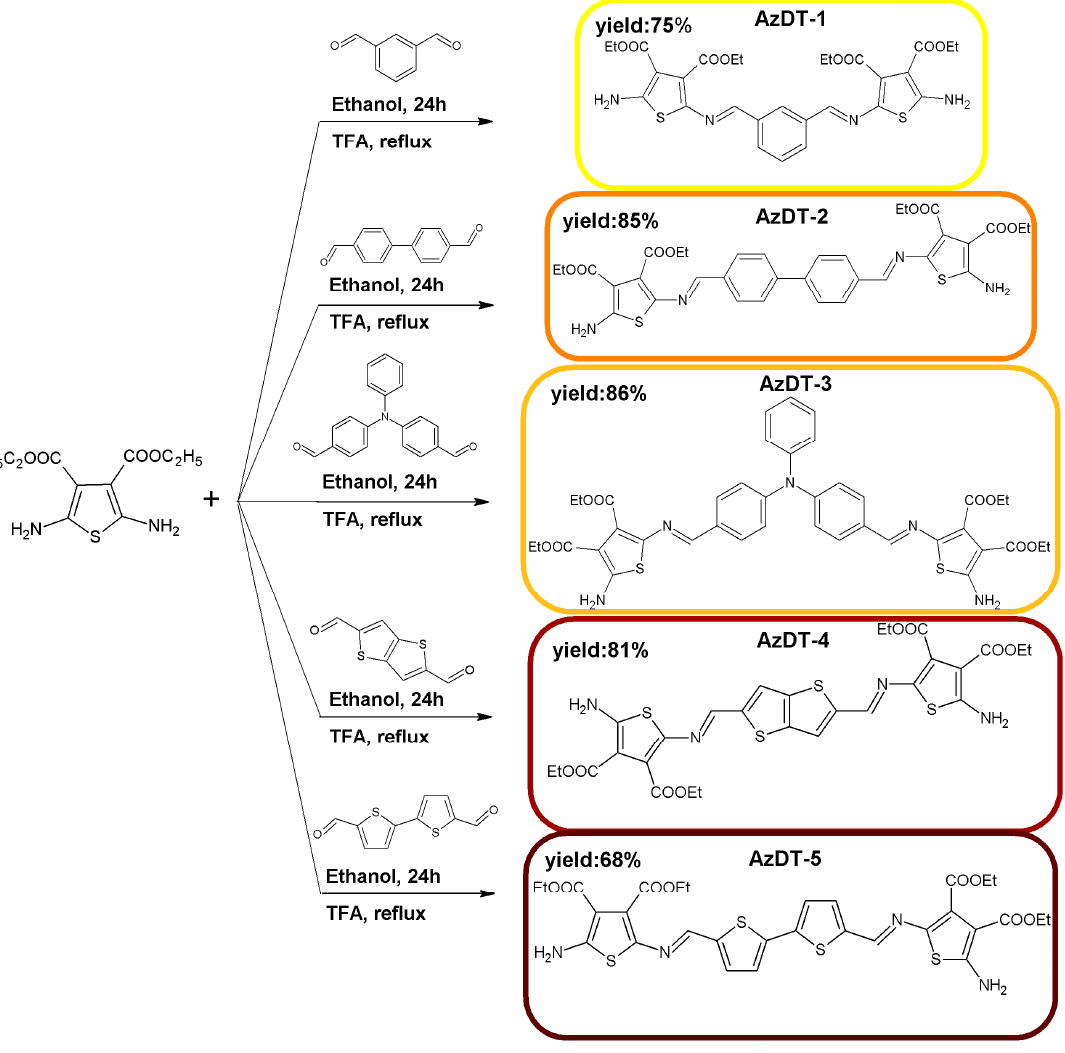
Figure 1. Synthesis route of thiophenoazomethines preparation.